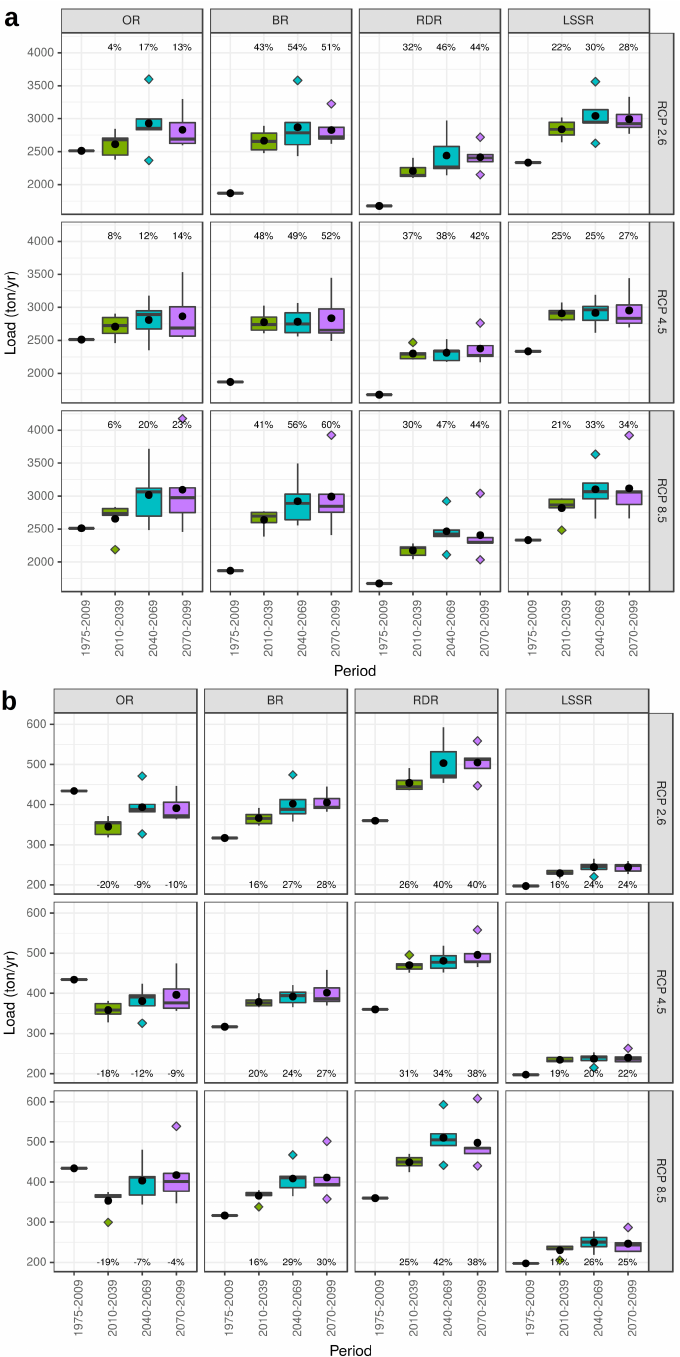
Figure 6. MultiGCM box plots (25, 50 (median) and 75 percentiles) of ( a ) total nitrogen (TN) and ( b ) total phosphorus (TP) predicted loads for each of the future periods, 2010–2039, 2040–2069 and 2070–2099, and RCP scenarios at the outlets of the main SSR basins, OR, BR, RDR and LSSR basins. Percentage changes with respect to the 1975–2009 TN average loads are shown. Box plot whiskers representing upper and lower extremes and outliers are also included in the box plots. The black filled dots represent nutrient load